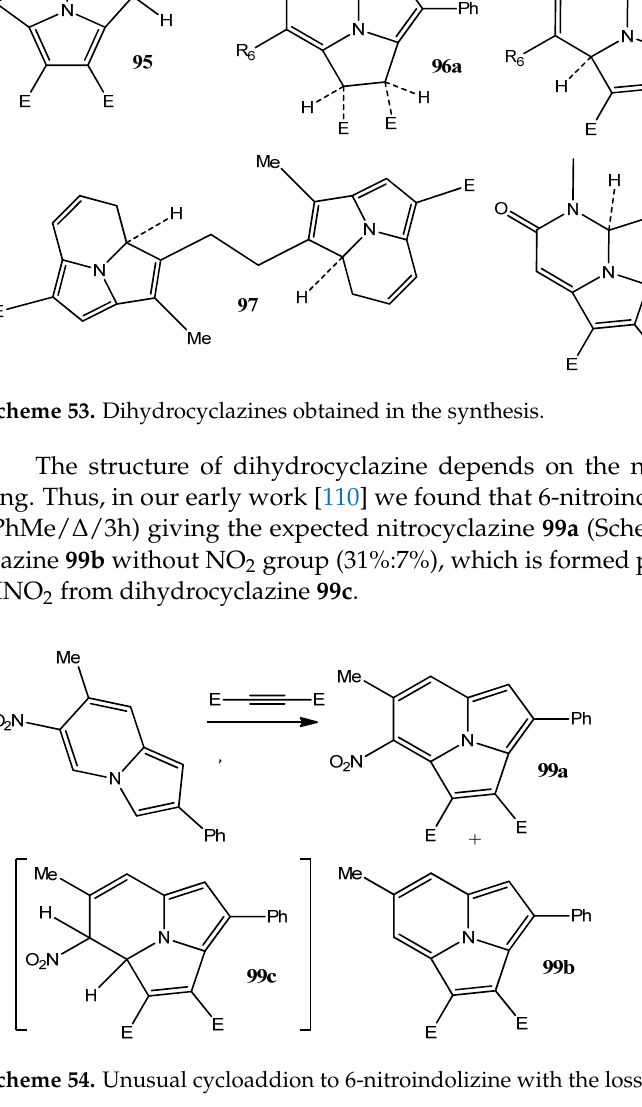
Scheme 55. 1:1 and 1:2 cycloadducts of 5-methylindolizine and DMAD.